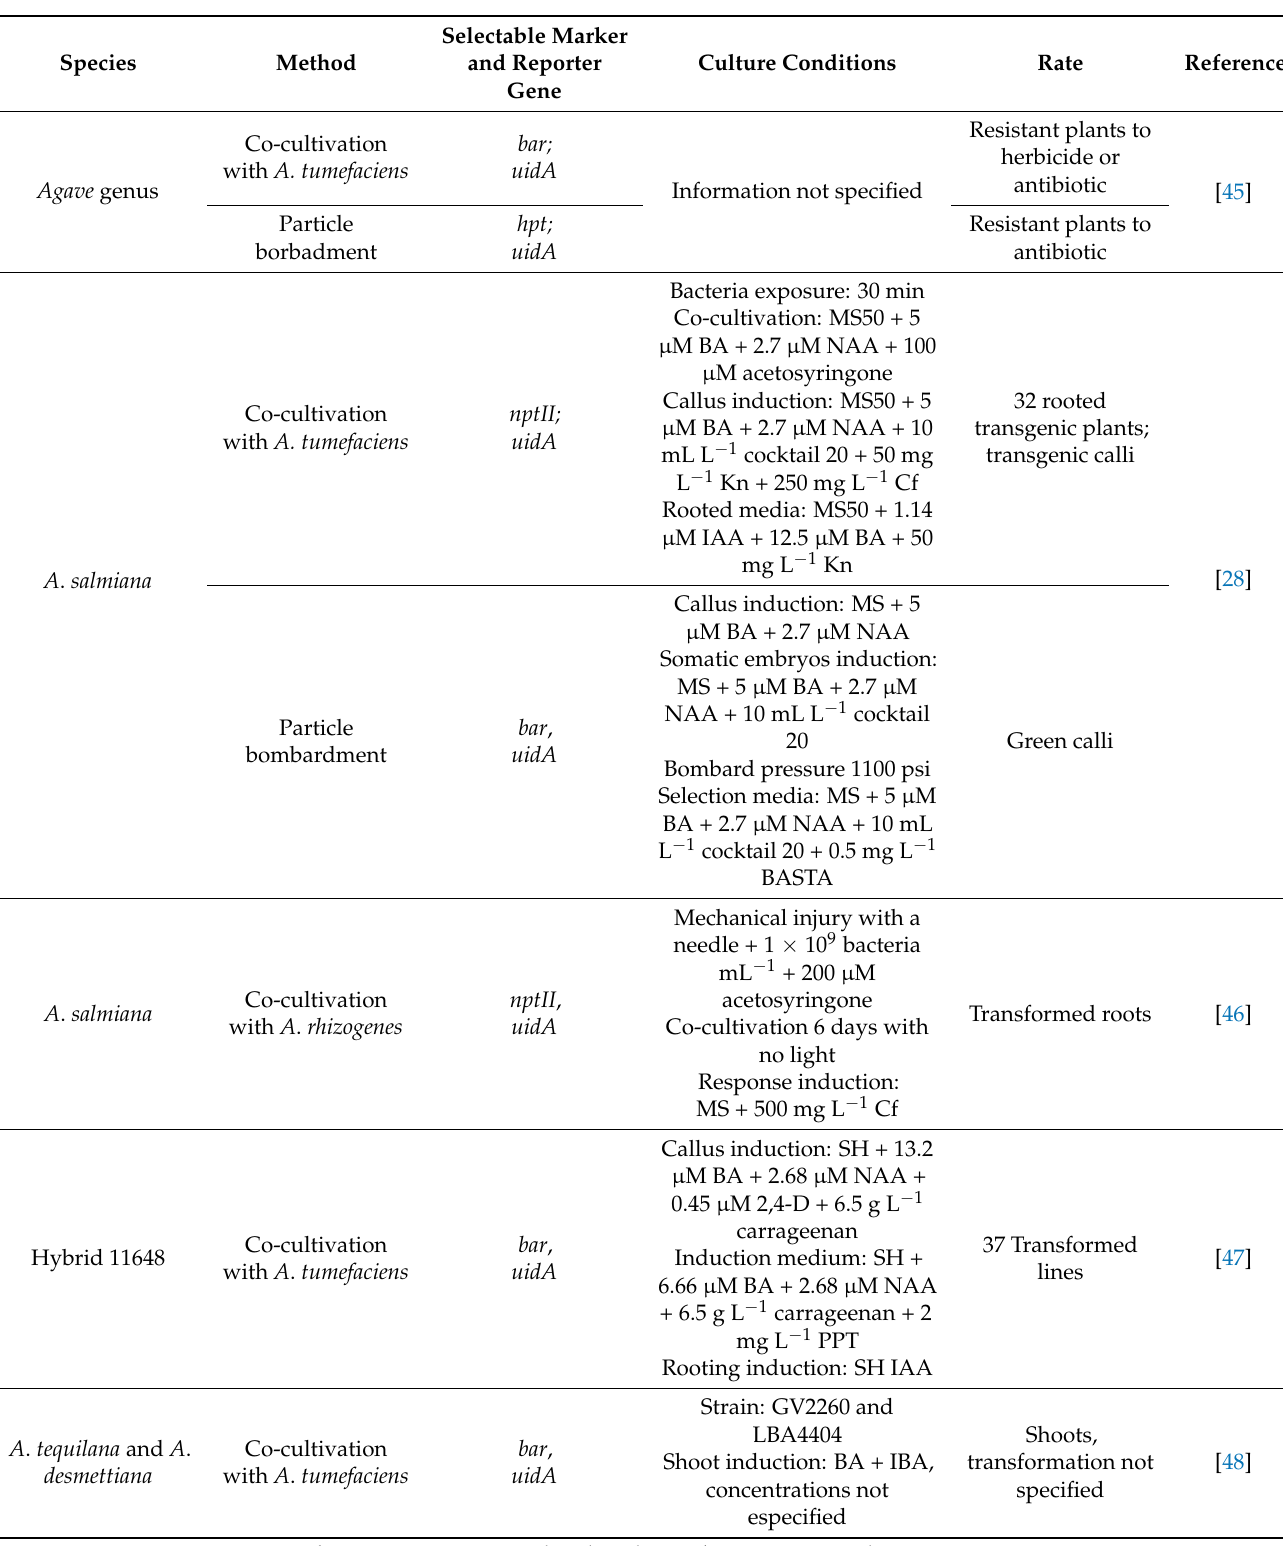
Table 3. Genetic transformation protocols for Agave